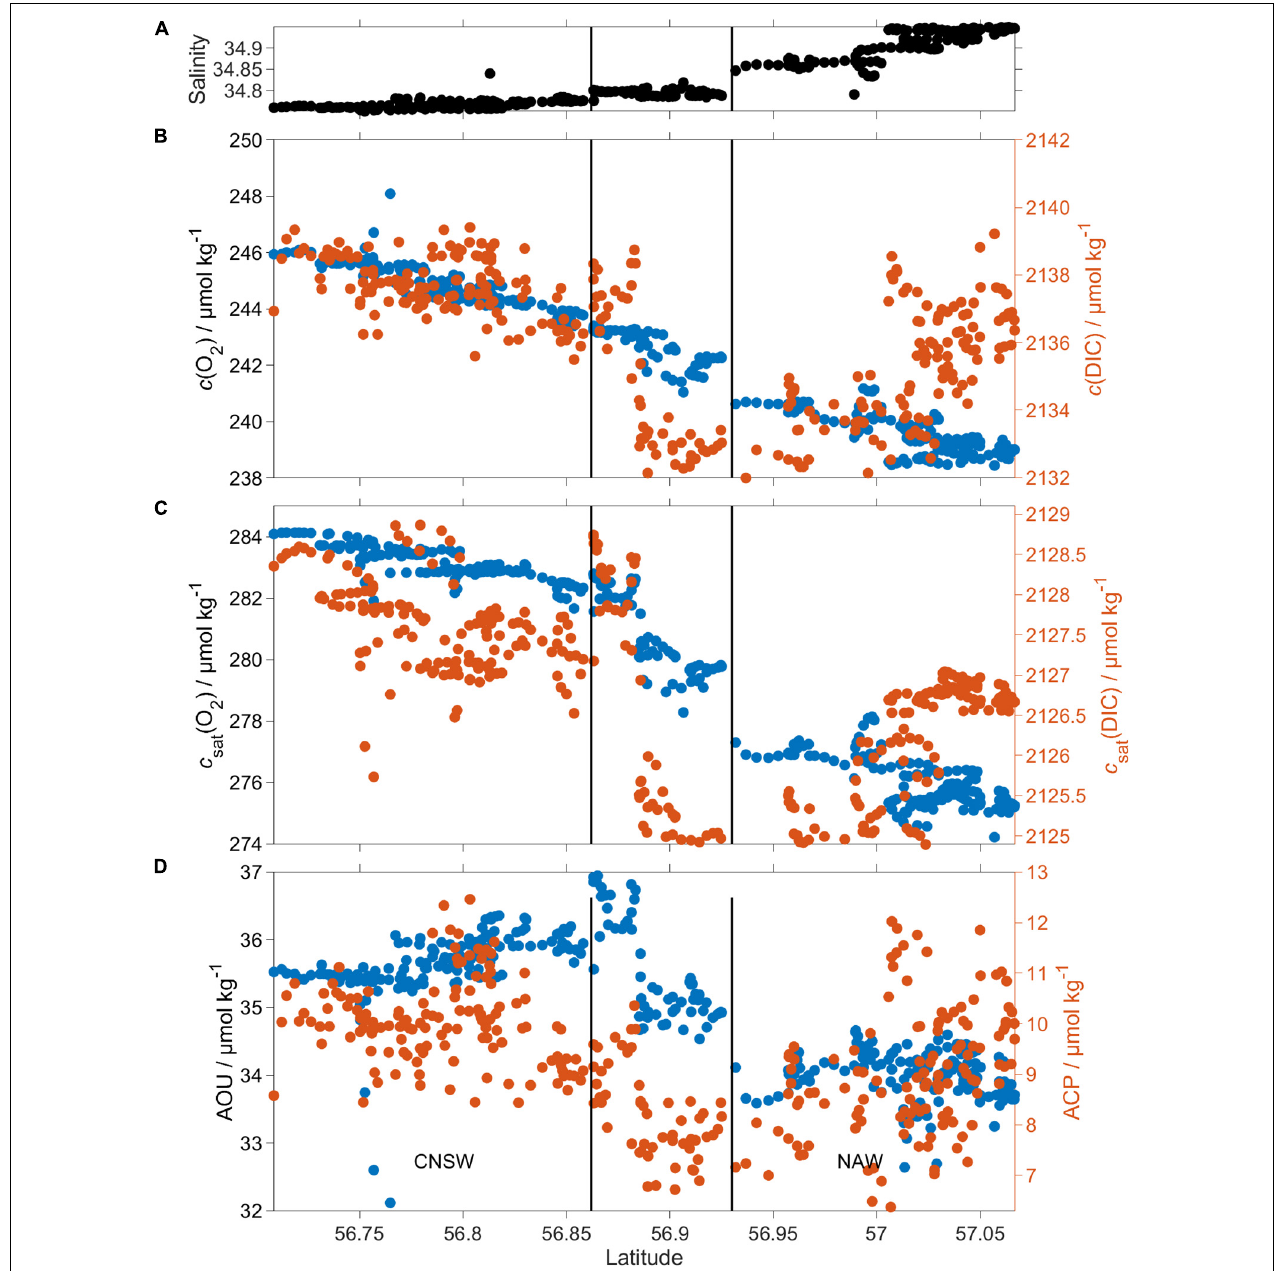
FIGURE 10 | ACP and AOU in the BML for CNSW and NAW. (A) Shows the increase of S ( z > 60 m) from south to north, while (B) c (DIC) (red) and c (O 2 ) (blue), (C) c sat (DIC) (red) and c sat (O 2 ) (blue), and (D) ACP (red) and AOU (blue) are lower in NAW than CNSW. The black vertical lines divide the three regimes defined in section “Three Different Regimes Along the Glider